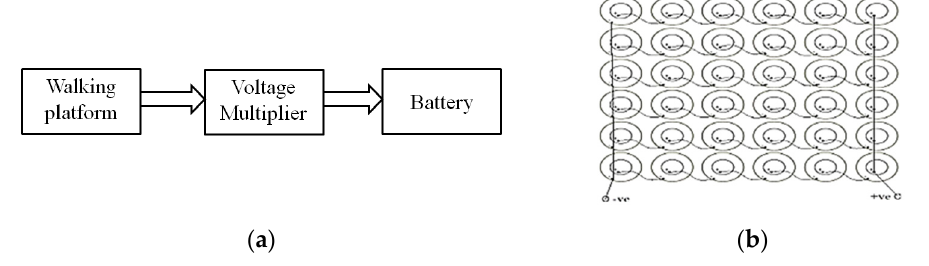
Figure 1. ( a ) Block diagram of PZT-based tiles’ energy generation, and ( b ) layout of walking tile platform .